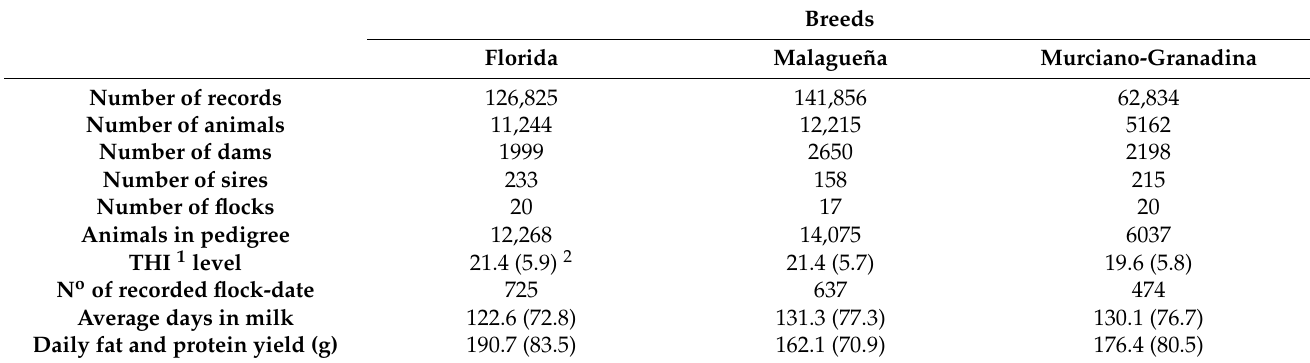
Table 1. Population parameters of the three analyzed dairy goat